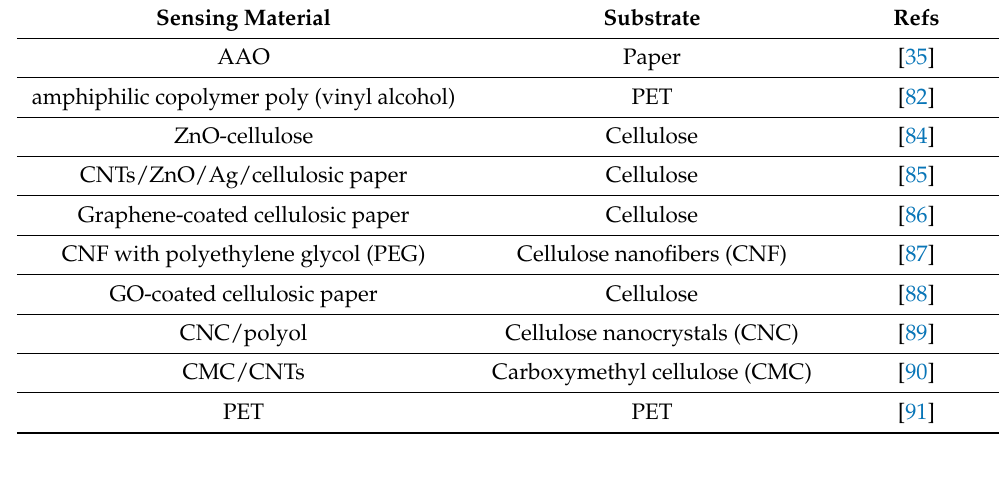
Table 2. Humidity sensors using polymer substrates for flexible devices.